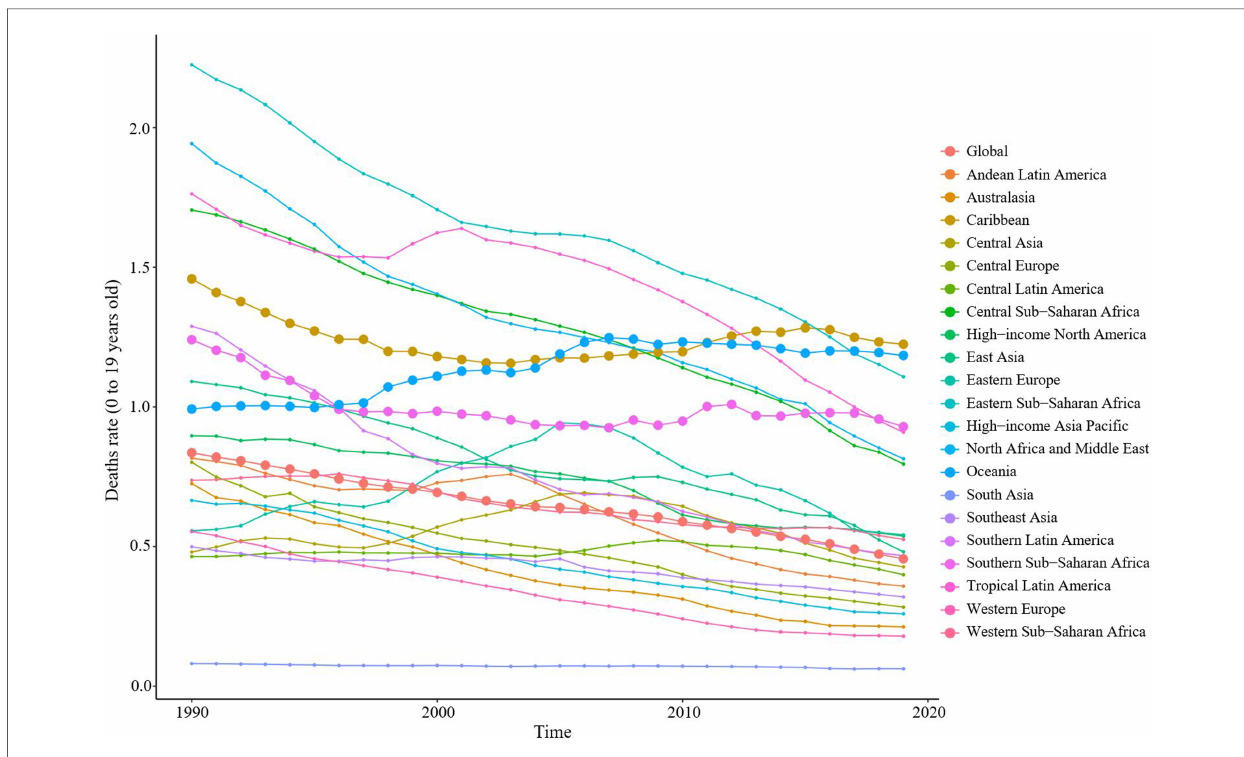
FIGURE 5 Trends in mortality of childhood myocarditis and cardiomyopathy in 21 regions from 1990 to 2019. From 1990 to 2019, the mortality rates from childhood myocarditis and cardiomyopathy showed a gradual decline in most regions of the world. However, it is on the rise in the Caribbean, Oceania and southern sub-Saharan Africa.